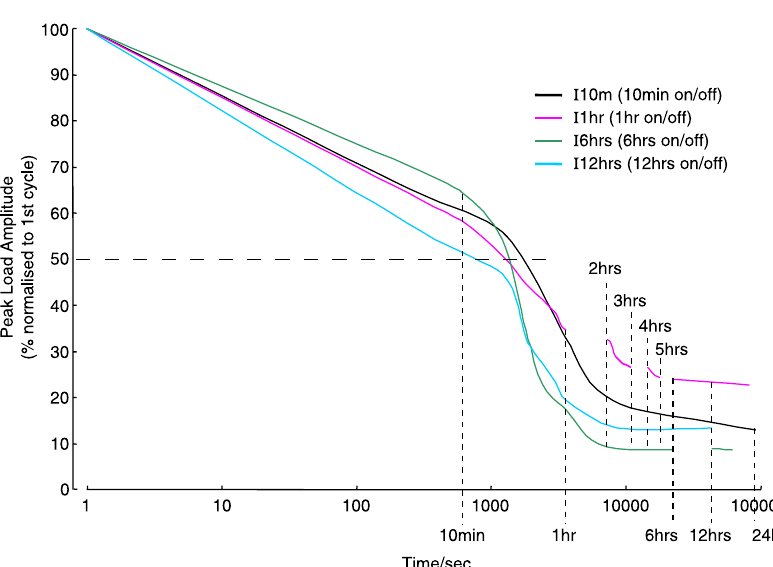
Fig. 2 Averaged peak load amplitude histories from strained fascicles subjected to intermittent straining regimes, normalised to the amplitude of the first cycle. Load was only recorded during strain periods. Data for 10 min intermittent regime (I10m) and data for 1hr regime (I1hr) after 6 hours are shown as a consecutive curve. The 50% level of 1st peak load is indicated with a horizontal dotted